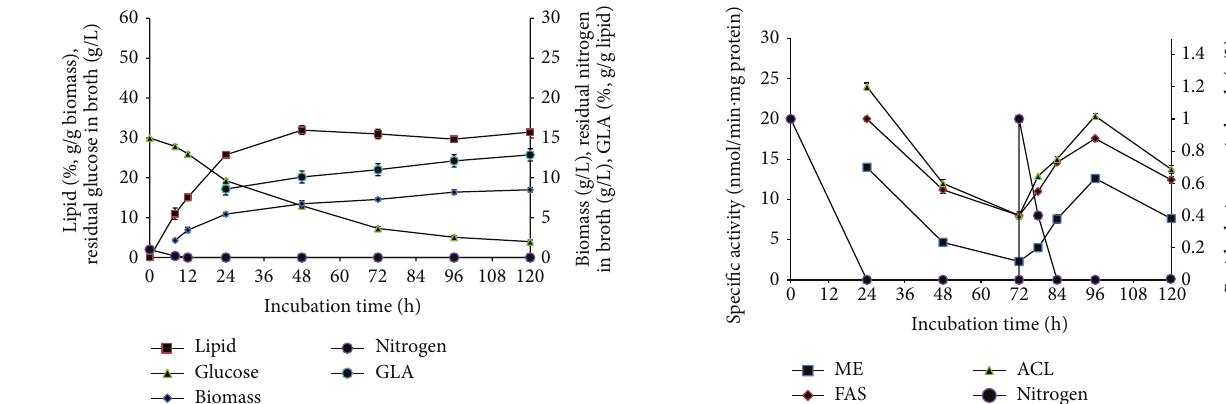
As glucose concentration at the point of feeding was low, the experiment was repeated with simultaneous feeding of concentrated ammonium tartrate and glucose to reach their initial concentrations (1 and 30 g/L, resp.) at 72 hours